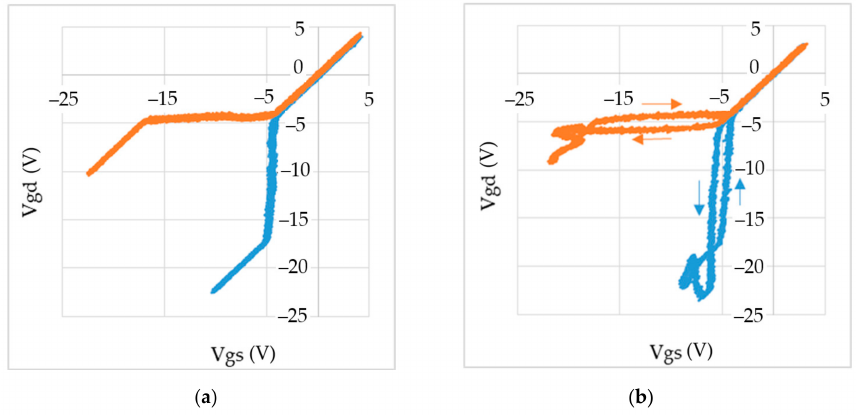
Figure 5. Results of the triangular wave on–off experiment of GaN HEMT at ( a ) 1 kHz and ( b ) 800